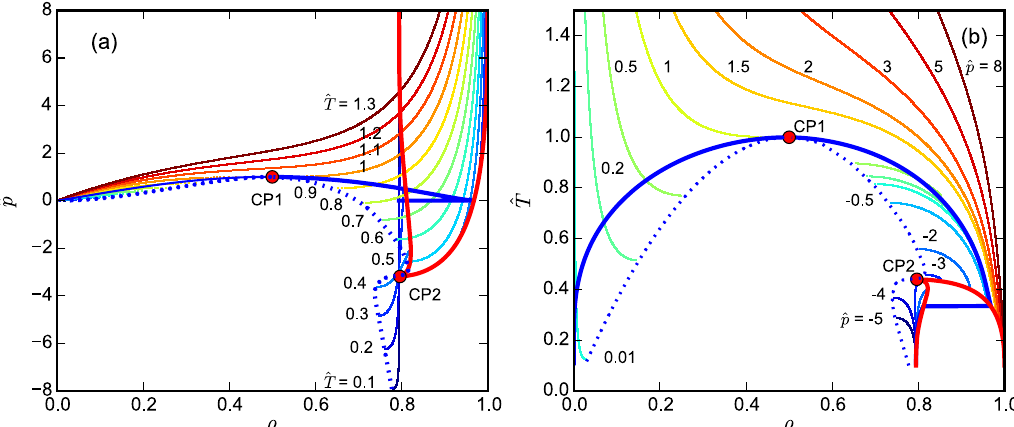
FIG. 5. A singularity ( “ bird ’ s beak ” ) in the liquid-liquid coexistence curve if the critical point coincides with the liquid-vapor spinodal. (a) Pressure-density, (b) Temperature-density. Thick blue curve is the vapor-liquid coexistence; thick red is the liquid-liquid coexistence; CP1 and CP2 are the vapor-liquid and liquid-liquid critical points, respectively; dotted blue is the liquid-vapor spinodal; multicolor curves are selected isotherms (a) and selected isobars